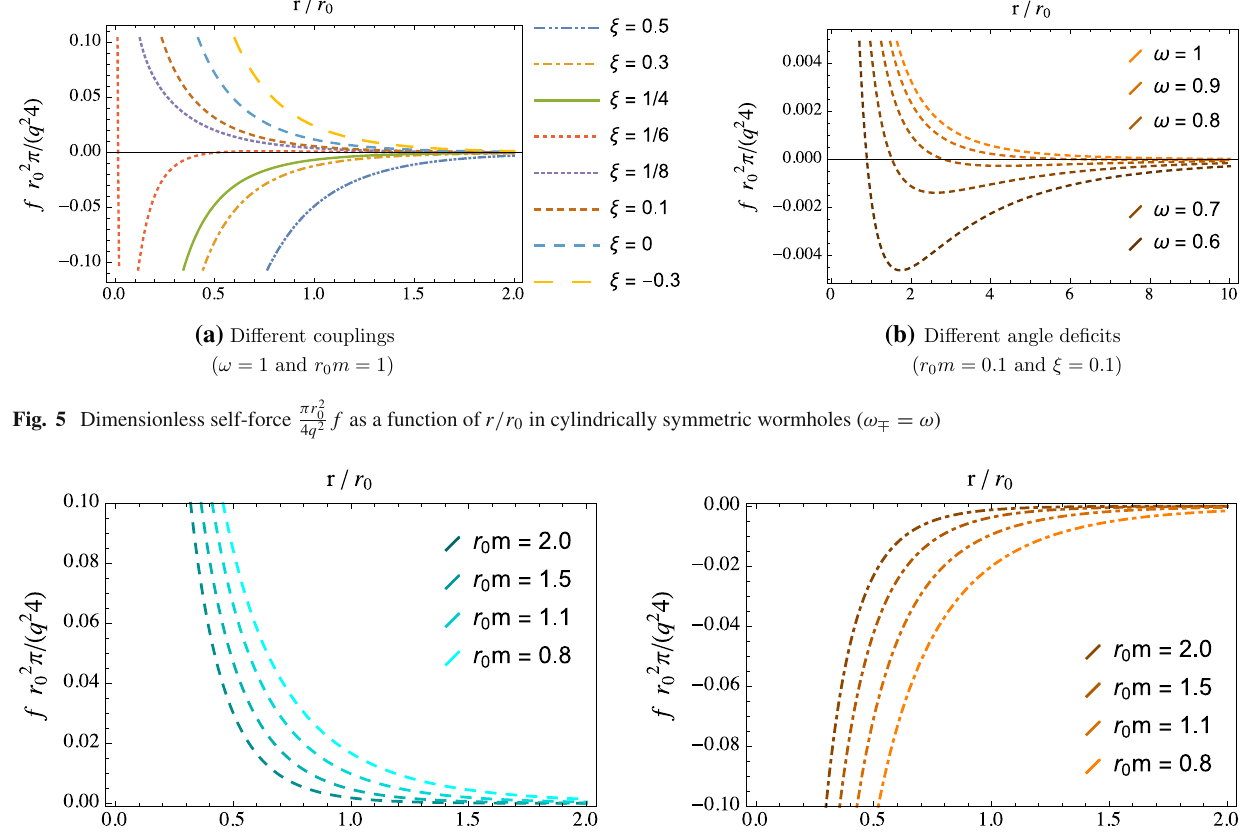
π r 2 f as a function of r / r 0 in a Minkowski cylindrical wormhole ( ω ∓ = 1) and different values of r 0 0 4 q 2